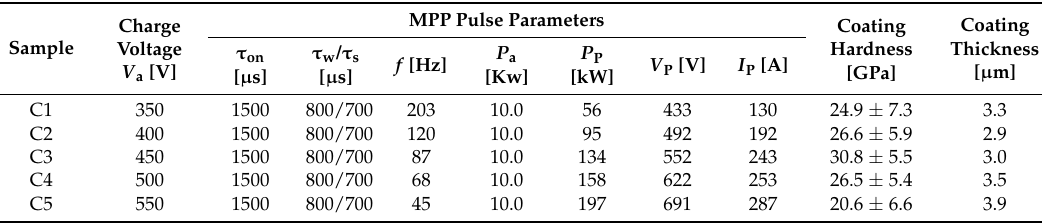
Figure 1. Typical waveform and parameters of the modulated pulsed power (MPP) power pulses. τ on : the pulse-on time; τ w : the weakly ionized pulse time; τ s : the strongly ionized pulse time; f : the pulse frequency; P a : the average target power; P P : the peak power of the pulses; V P : the peak voltage of the pulses; I P : the peak current of the pulses. Table 1. Deposition parameters using different modulated pulsed power magnetron sputtering (MPPMS) charge voltages in this study.